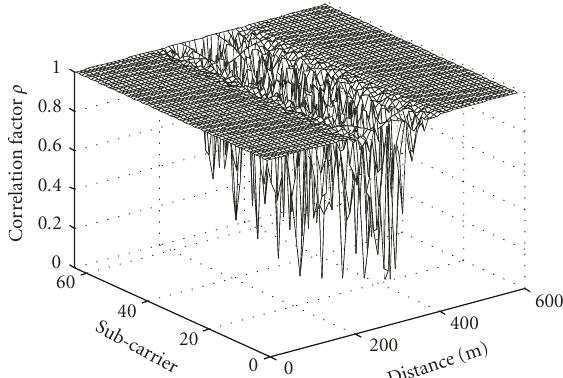
Figure 7: Characteristic of correlation factor ρ over the subcarriers depending on the distance d 0 .